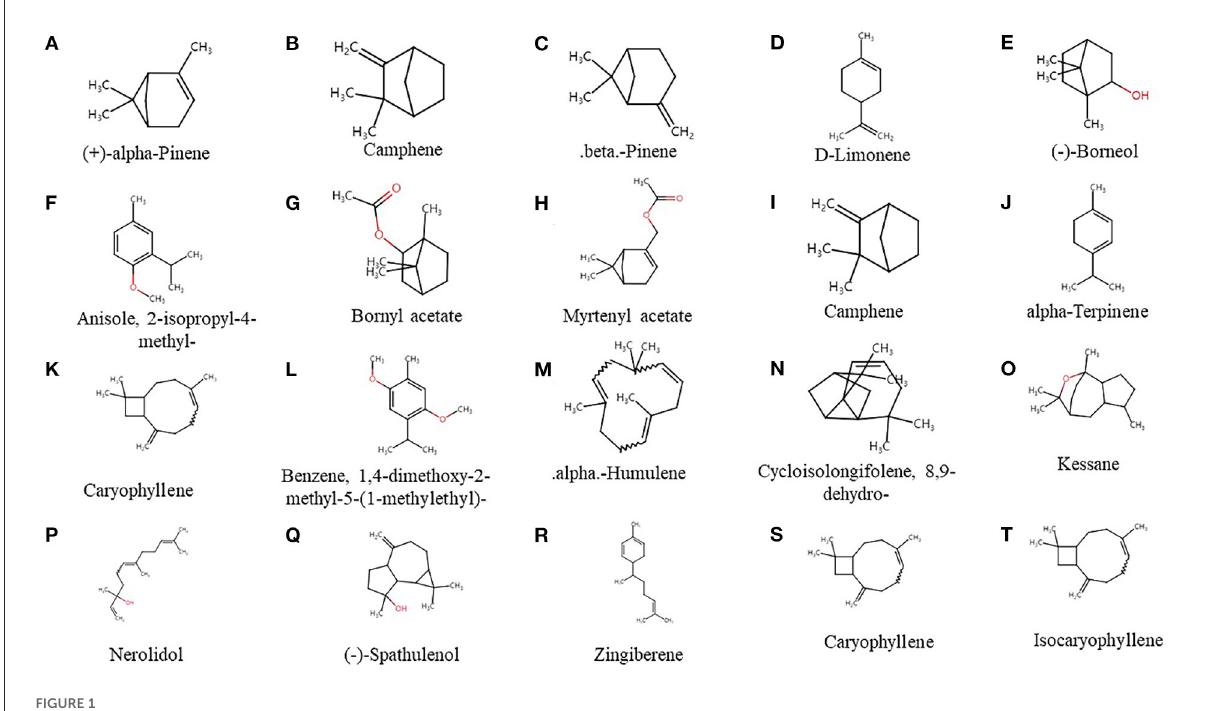
FIGURE1 (A–T) Chemical structures of 20 active